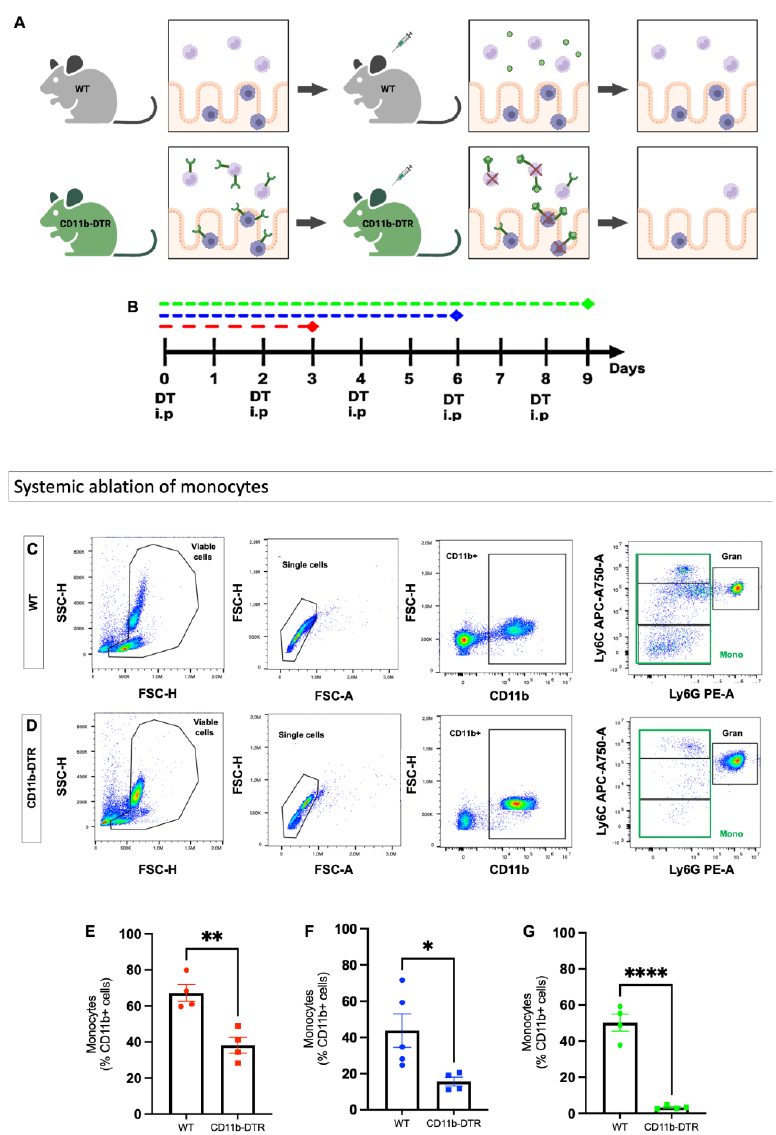
Figure 2. Temporally controlled diphtheria-toxin-induced monocyte depletion. ( A ) Diphtheria toxin receptor (DTR) in CD11b-DTR mice allows the specific systemic and local ablation of monocytes and macrophages by injecting diphtheria toxin (DT) intraperitoneally (i.p.), while wildtype (WT) mice are naturally resistant. ( B ) DT treatment scheme with a varying duration of DT treatment. Mice were treated with DT for 3 (red), 6 (blue) or 9 (green) days. Gating strategy for identification of circulating monocytes (mono) in ( C ) WT and ( D ) CD11b-DTR mice; representative flow cytometry plots are shown. Viable cells are identified on a forward scatter-height (FSC-H) x side scatter (SSC-H) plot, while single cells are identified on an FSC-H x FSC-area ( A ) plot. Next, CD11b x FCH-H gating was used to identify CD11+ positive cells, which were gated in two parameter density plots with Ly6G and Ly6C. Monocytes were defined as CD11b + Ly6G low Ly6C + cells. Numeric data for circulating monocytes subsets mice following ( E ) 3, ( F ) 6, or ( G ) 9 days of treatment. All data are presented as mean values ± SEM, combined from 2 independent experiments with 4 to 5 individually analyzed mice per group. Each symbol in scatter plots represents 1 individual mouse. Data were analyzed with Student’s t test and significance is indicated by the following symbols: * p < 0.05, ** p < 0.01, **** p < 0.0001 vs.